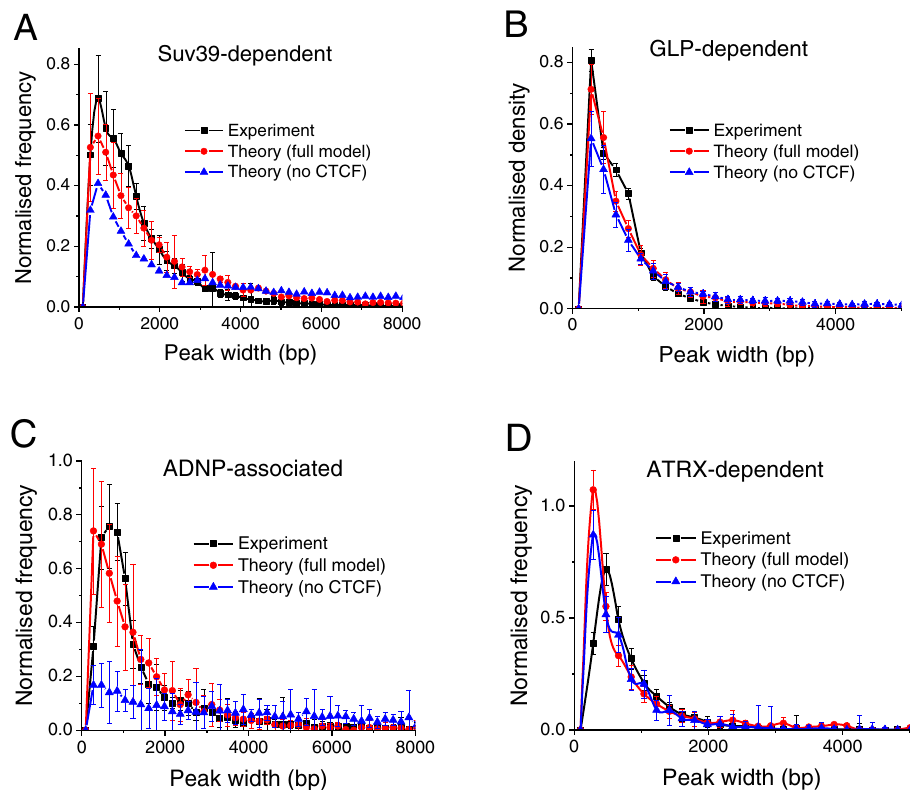
Fig. 4 ChromHL predictions compared with the experimental distribution of HND sizes. The experimental nanodomain sizes given by H3K9-methylated ChIP-seq peaks (black) are plotted against the theoretically predicted ones calculated with ChromHL. The full model (red) and the simpli fi ed model without CTCF (blue) are shown. The mean and standard deviations of the bar heights of the histogram are shown, averaged over chromosomes 1-19 and X. Detailed best fi t parameters are given in Supplementary Table 3. A SUV39H-dependent HNDs. B GLP-dependent HNDs. C ADNP-associated HNDs. D ATRX-dependent HNDs computed with the L1 repeats-based model. σ = 1 for SUV39H-, GLP- and ADNP-HNDs, and σ = 0.01 for